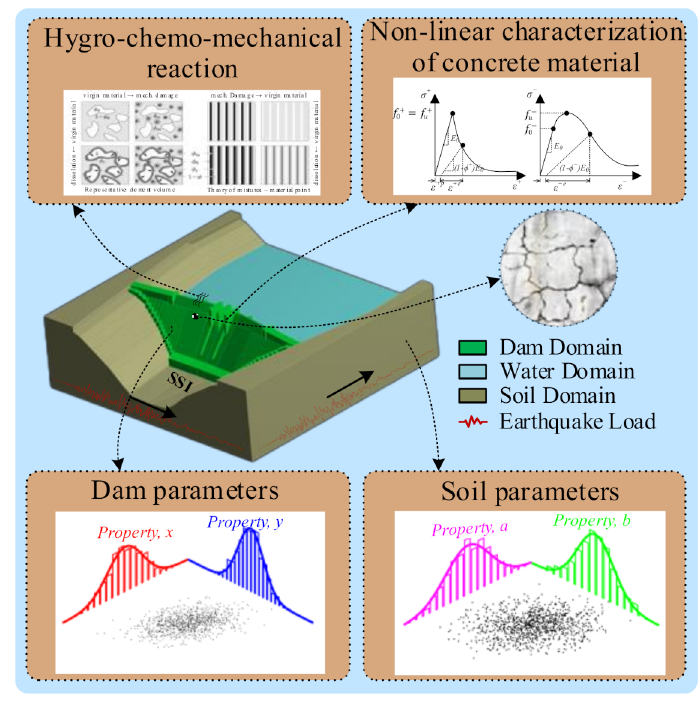
Figure 6. Epistemic uncertainties consideration in 3D